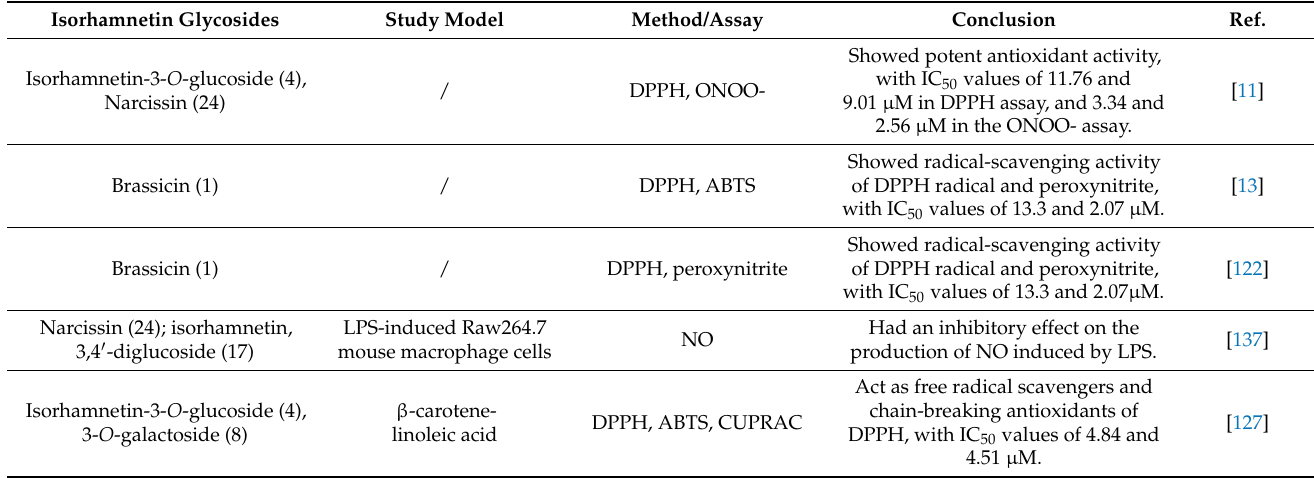
Table 2. Antioxidant activity of